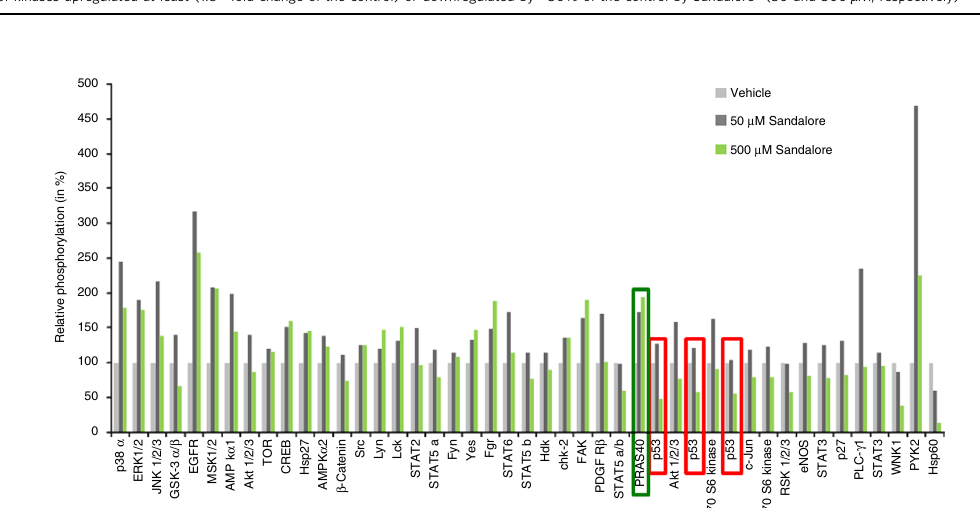
Fig. 7 OR2AT4 stimulation by Sandalore ® treatment regulates different protein phosphorylation signaling pathways in human HFs ex vivo. Plot showing regulation of the phosphorylation of 45 kinases mediated by Sandalore ® (50 and 500 µ M) in cultured microdissected HFs from four different donors (independent experiments). Among those kinases, the most interesting ones underline in green (upregulated) and red (downregulated) rectangles. PRAS40 proline-rich AKT1 substrate 40 49 , S46 phosphorylated p53 50 , p53 phosphoprotein p53, p38 α mitogen-activated protein kinases 14, ERK1/2 extracellular signal-regulated kinases1/2, EGFR epidermal growth factor receptor, MSK1/2 mitogen- and stress-activated protein kinase 1/2, PYK2 protein tyrosine kinase 2, Hsp60 heat shock protein 60, JNK1/2/3 c-Jun N-Terminal Protein Kinase 1/2/3, AMPK α 1 AMP-activated protein kinase α 1, PLC γ phospholipase C γ 1, Fgr Feline Gardner-Rasheed proto-oncogene, WNK1 WNK lysine-de fi cient protein kinase 1